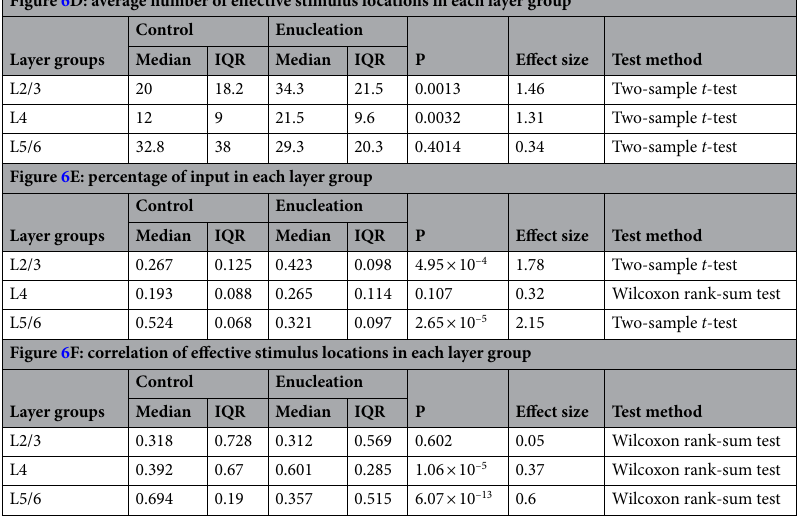
Figure 6D: average number of effective stimulus locations in each layer group